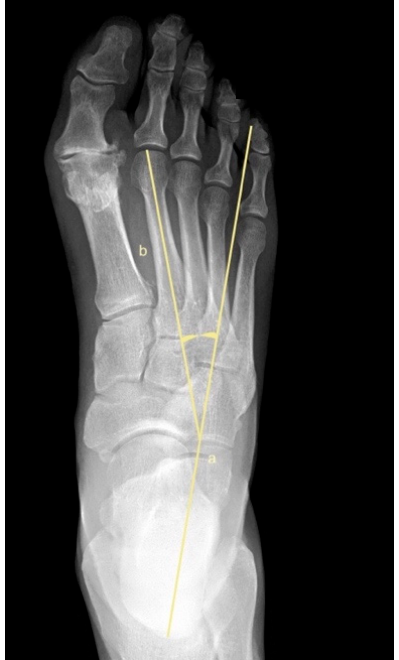
Figure 4. Dorsoplantar weightbearing radiograph of Root’s angle. Engel’s angle [34], Figure 5, is the angle between the longitudinal axis of the second cuneiform as shown at line (b) and the longitudinal axis of the 2nd metatarsal bone as shown at line (a).